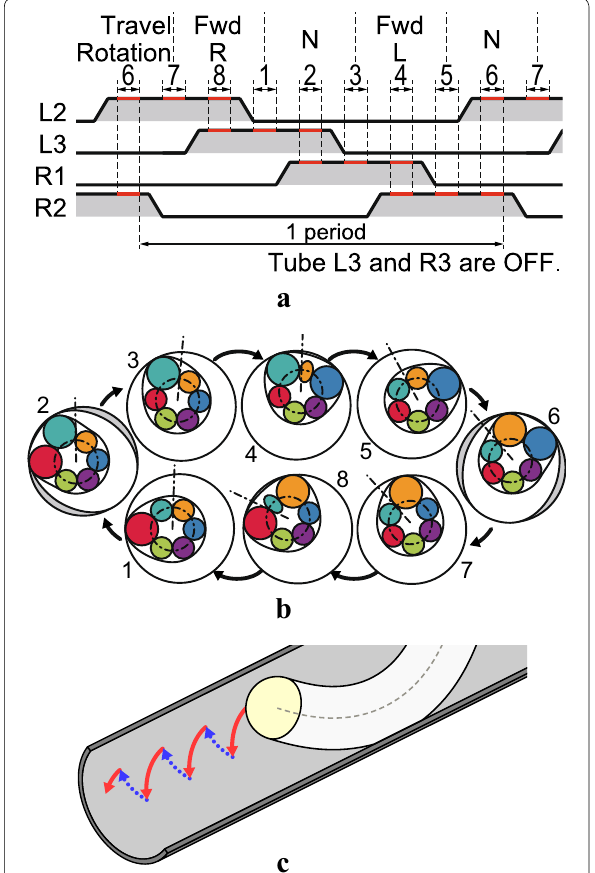
Fig. 4 Four-tube-driven locomotion with a steering hook. a – c The pressurization pattern for four-tube travel, the deformation of the device driven by four tubes, and the locomotion trajectory driven by four tubes. In c , the device switches a travel trajectory between a right-handed helix (a red and solid arrow) and a left-handed helix (a blue and dotted arrow)